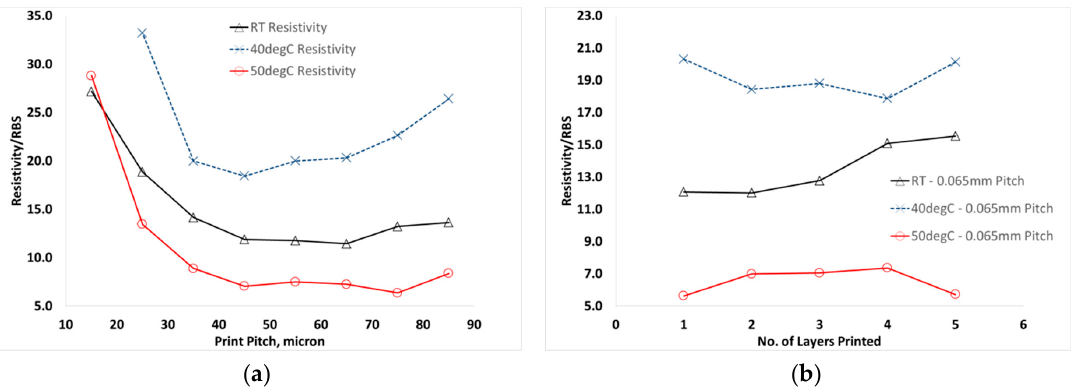
Figure 8. E ff ect of substrate temperature on ( a ) line resistivity with varying dot spacing and ( b ) line resistivity with number of layers printed.